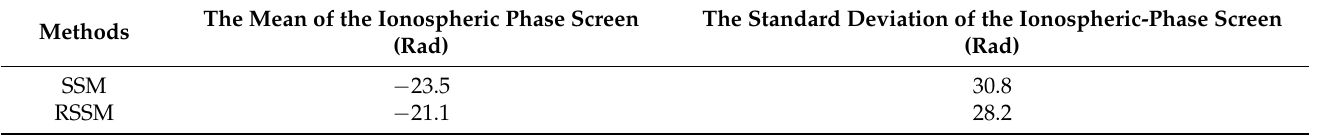
Table 2. Comparison of the mean and standard deviation of the ionospheric phase by SSM and RSSM.